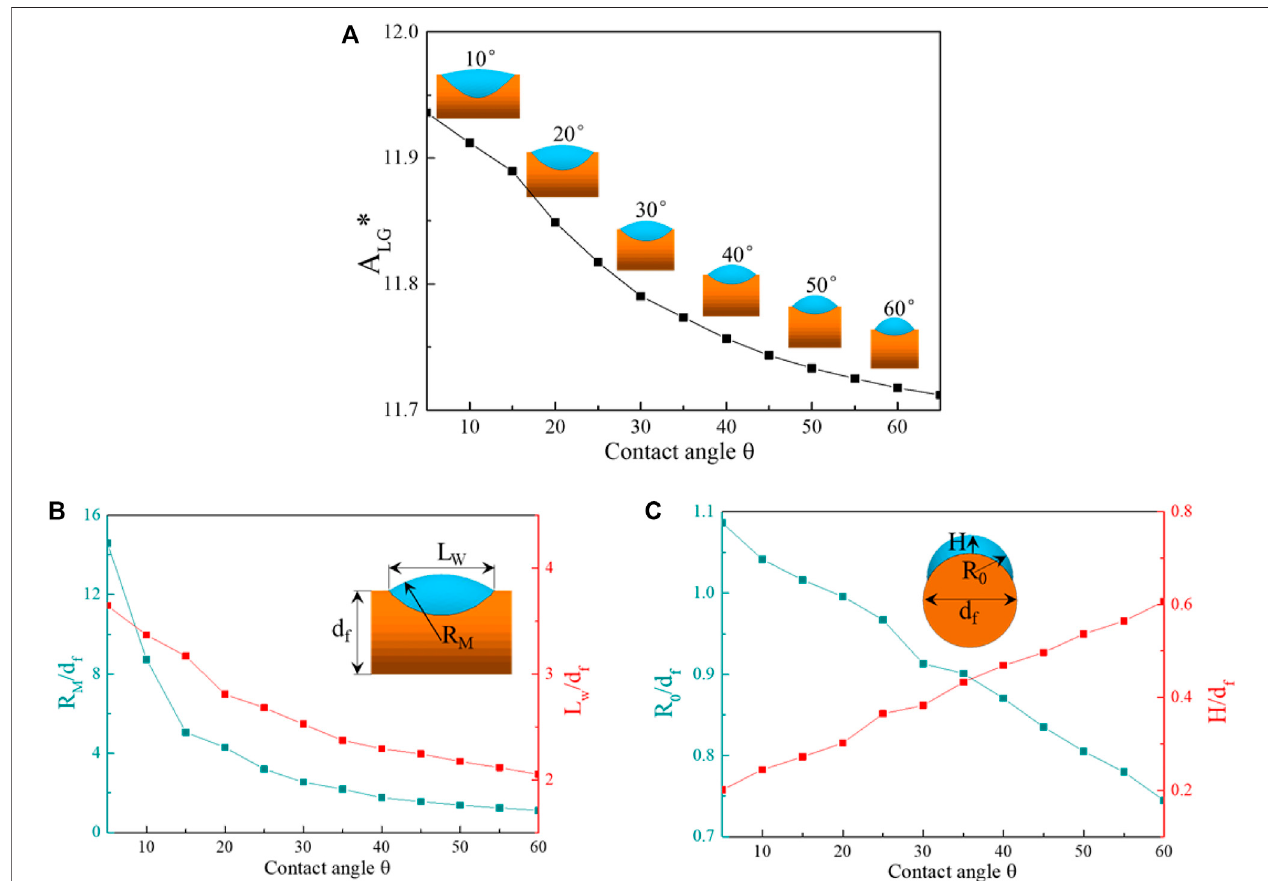
FIGURE3|(A) ChangeofdimensionlessfreesurfaceA LG *withcontactangle.Variationofdimensionlessgeometricparameterswithcontactangle: (B) R M *( R M / d f ) and L W * ( L W / d f ), (C) R 0 * ( R 0 / d f ) and H* ( H / d f